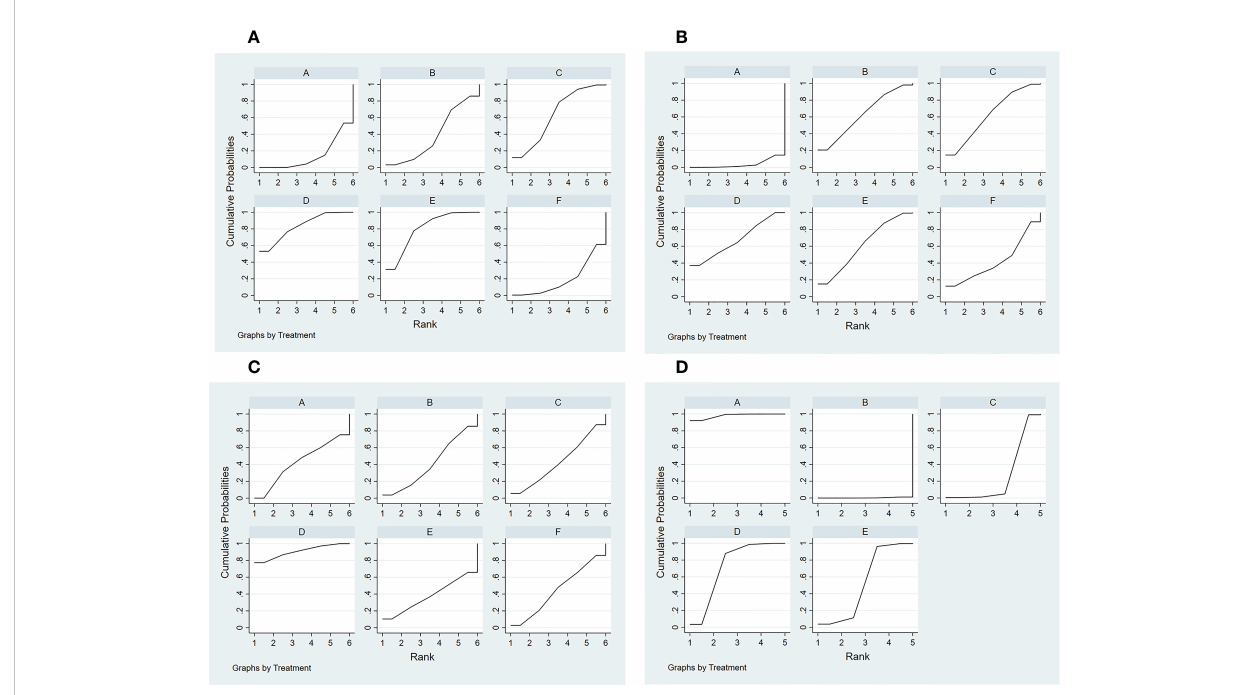
FIGURE 6 Curve diagram of SUCRA of outcome indicators. (A) good response rate; (B) complete response rate; (C) percent change from baseline in SALT score; (D) TEAE (treatment emergent adverse events) rate. A: placebo treatment B: conventional steroid therapy C: any dose of oral tofacitinib treatment D: any dose of oral baricitinib treatment E: any dose of oral ruxolitinib treatment F: nonoral JAK inhibitor treatment.